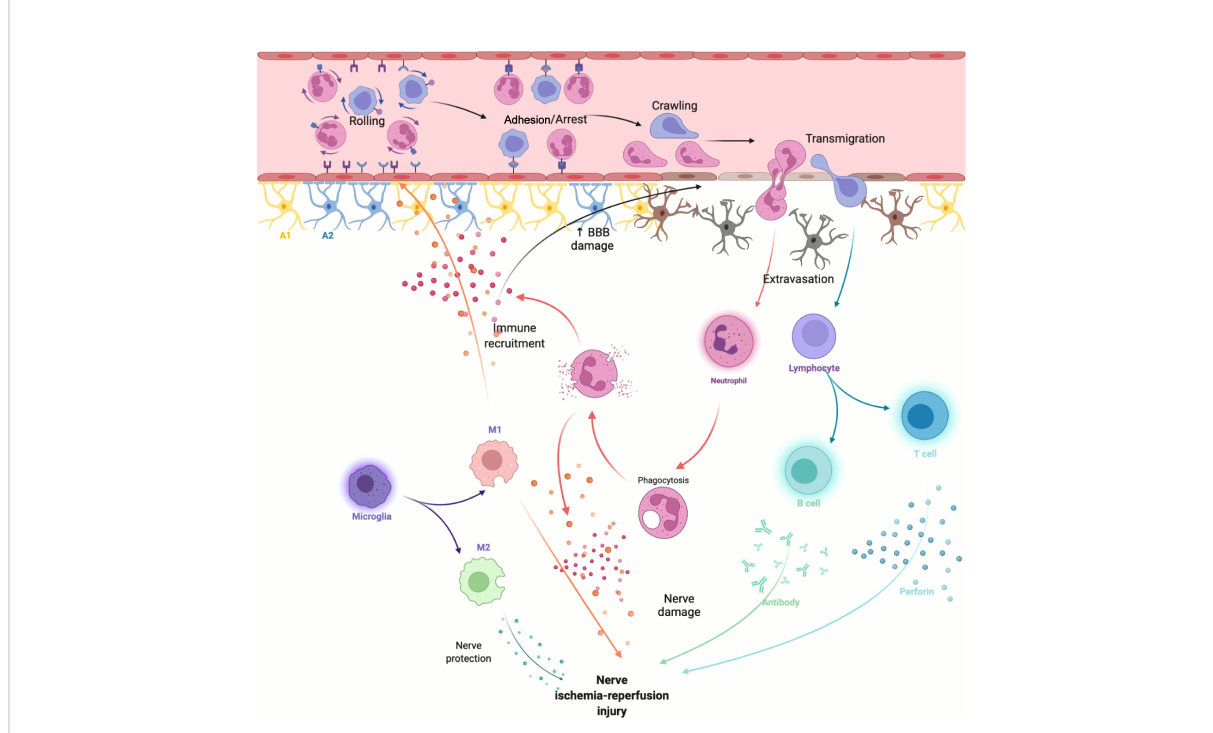
FIGURE 1 After cerebral ischemia-reperfusion injury, DAMPs released by necrotic cells activate innate immune cells in the CNS and attract peripheral immune cells to activate adaptive immune